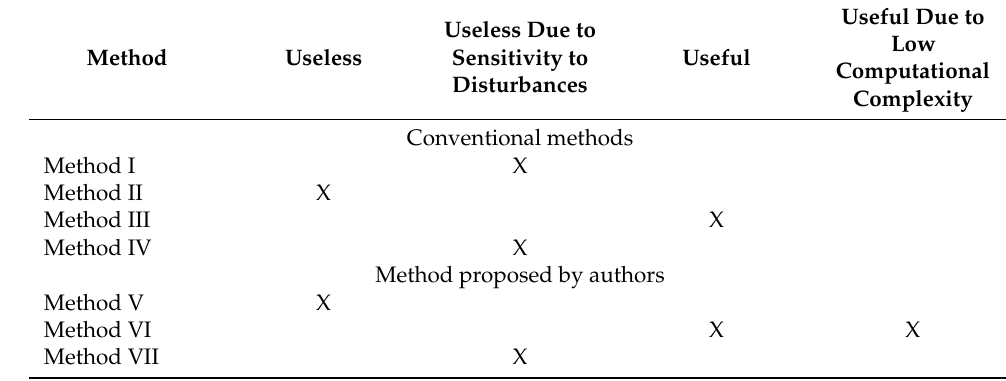
Table 9. Evaluation of